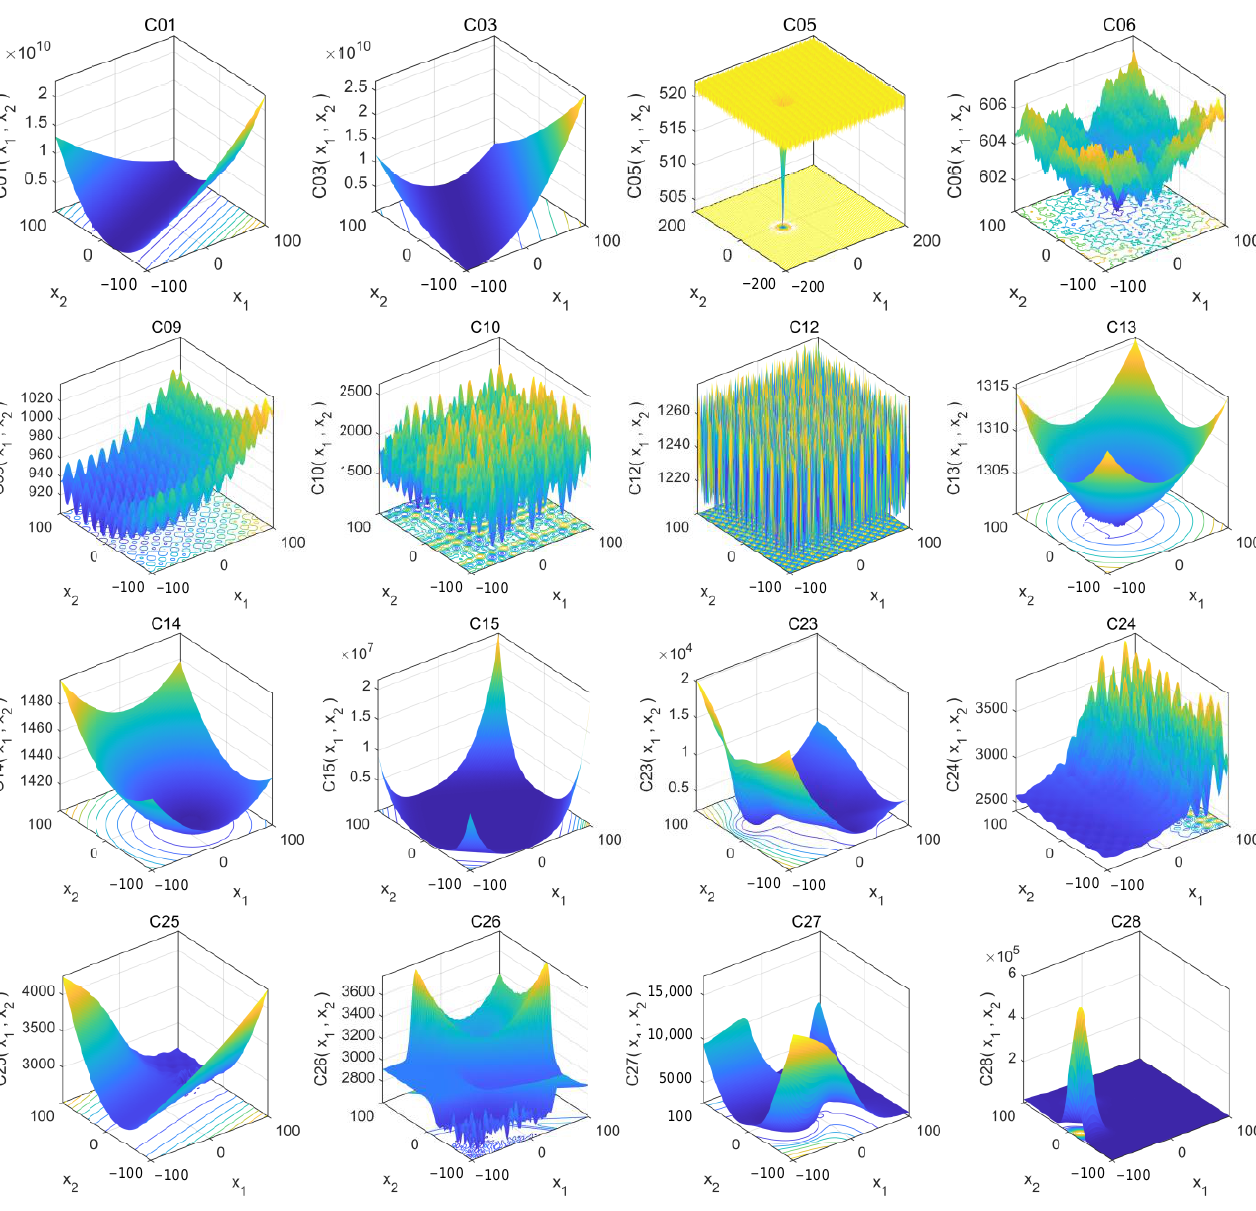
Figure 6. View of some CEC 2014 benchmark functions.